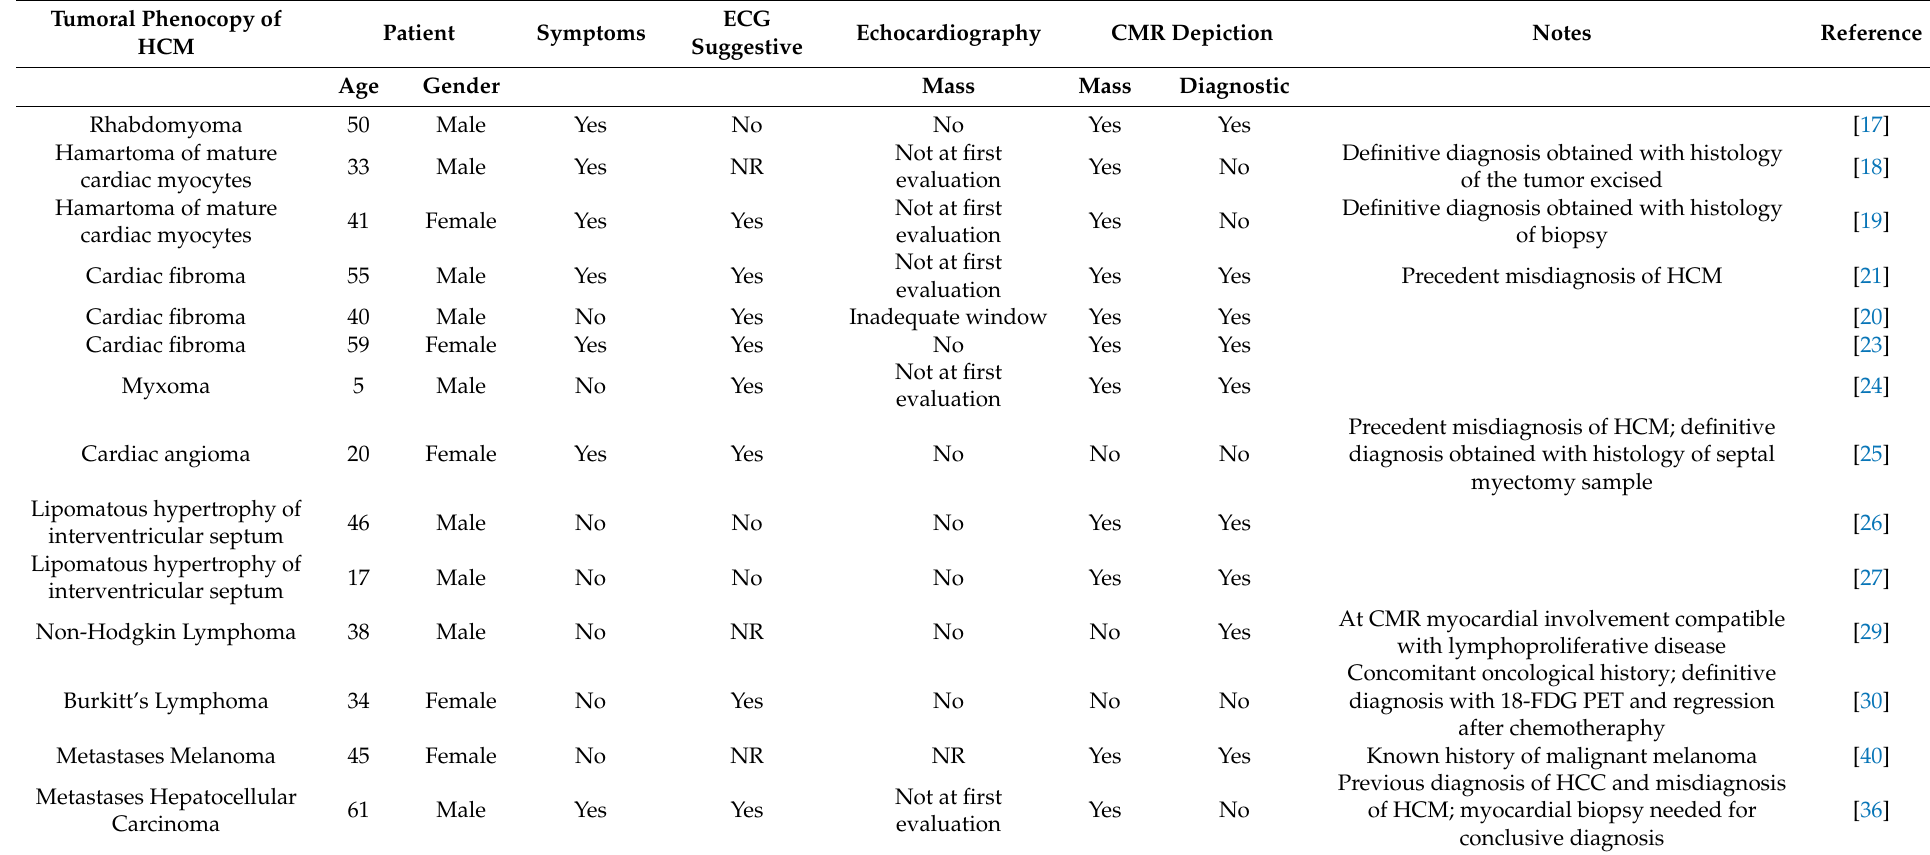
Table 3. Case reports describing a tumoral phenocopy of hypertrophic cardiomyopathy (HCM) in which cardiac magnetic resonance (CMR) was performed. Tumoral Phenocopy